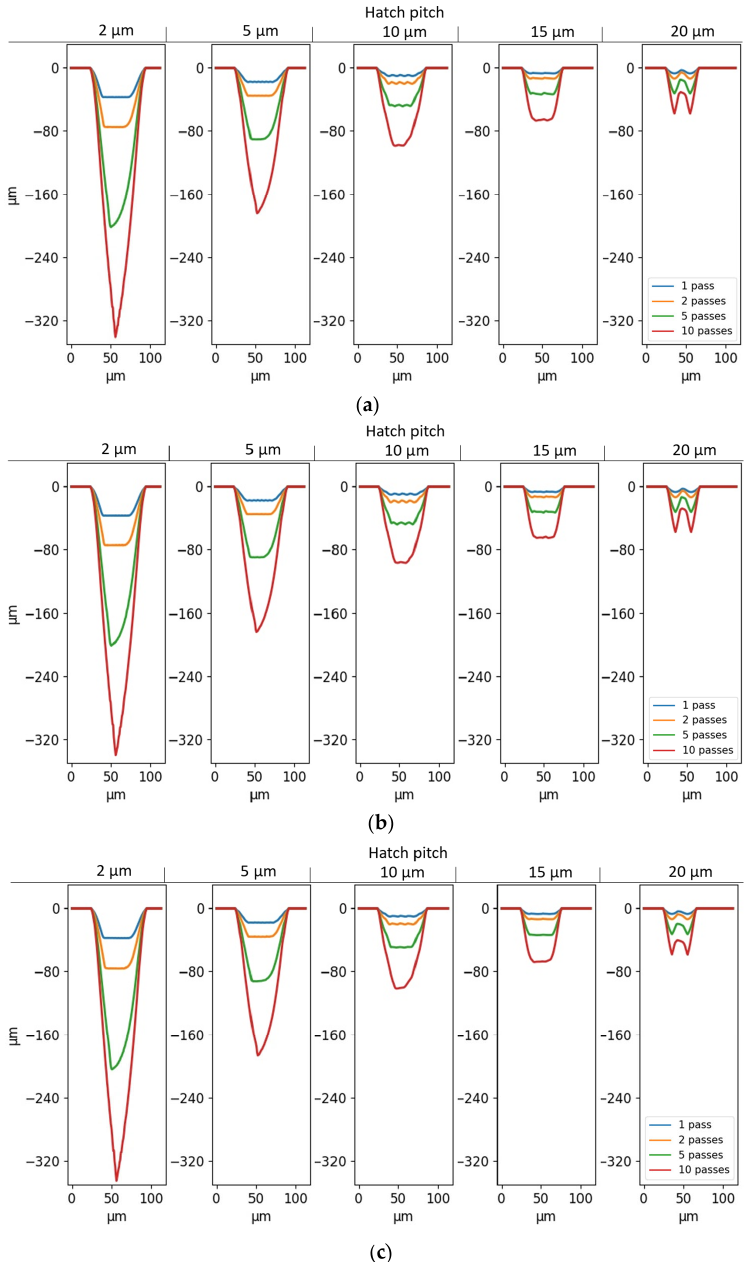
Figure 10. Simulated cross-sections of unidirectional grooves with geometry-dependent threshold fluence, as a function of hatch pitch and number of passes. ( a ) c F